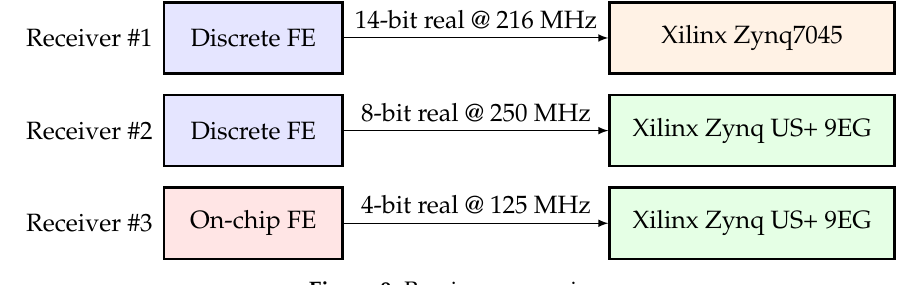
Figure 9. Receiver comparison.